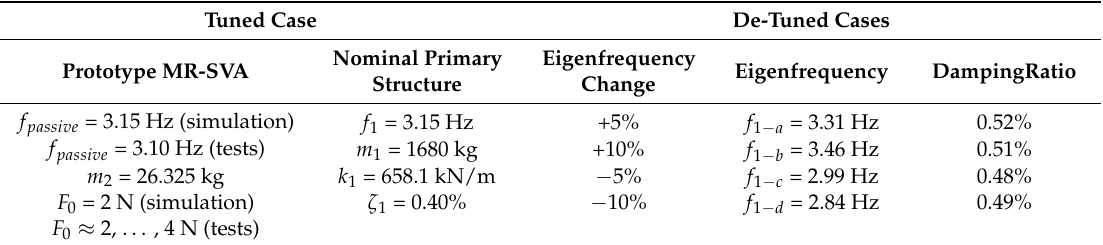
Table 1. Parameters of prototype MR-SVA, primary structure with nominal and changed eigenfrequencies. Tuned Case De-Tuned Cases Prototype